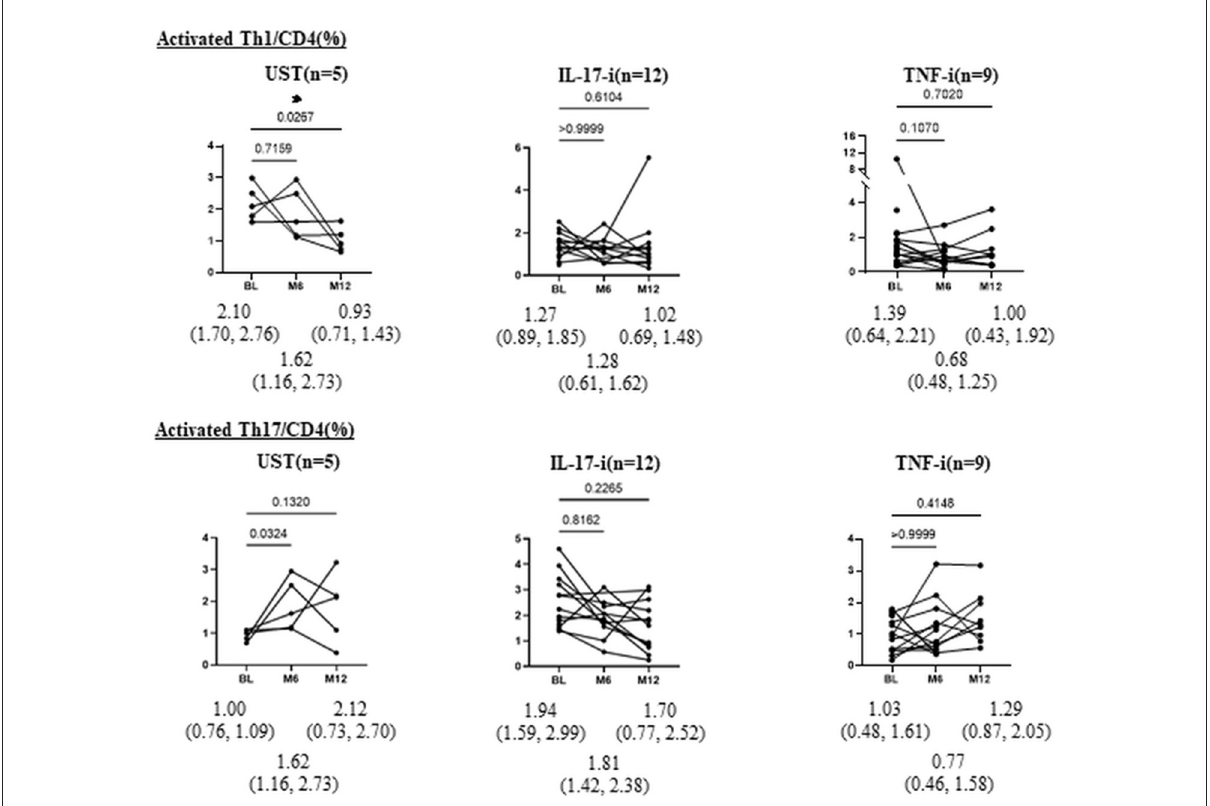
FIGURE2 Changes in proportion of aTh1/Th17 cells (%) after bDMARDs treatment. Data are presented as the median (interquartile range [IQR]). * P < 0.05, Wilcoxon signed-rank test. UST, ustekinumab; IL-17-i, IL-17 inhibitors; TNF-i, TNF inhibitors, index, aTh1: activated Th1 cells; aTh17, activated Th17